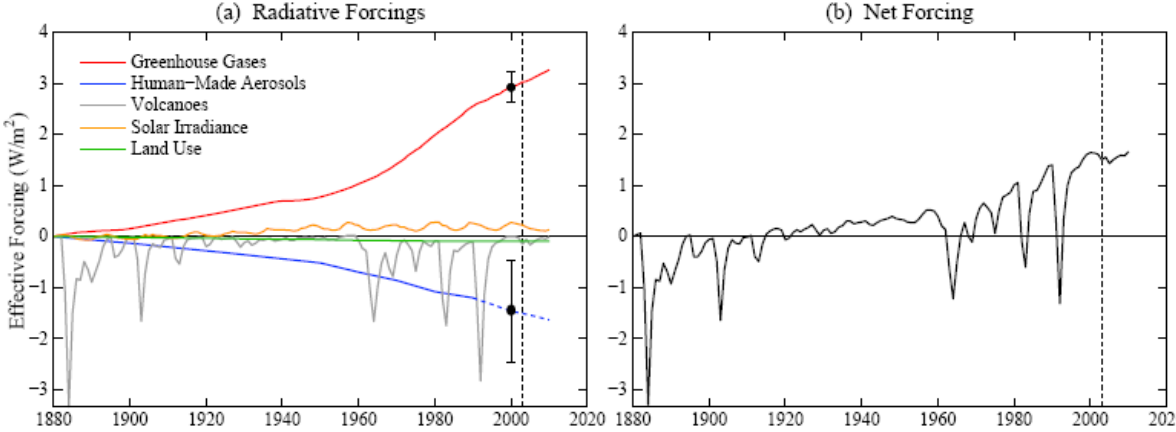
Fig. 1. Climate forcings employed in this paper. Forcings through 2003 (vertical line) are the same as used by Hansen et al. (2007), except the tropospheric aerosol forcing after 1990 is approximated as − 0.5 times the GHG forcing. Aerosol forcing includes all aerosol effects, including indirect effects on clouds and snow albedo. GHGs include O 3 and stratospheric H 2 O, in addition to well-mixed GHGs. These data are available at http://www.columbia.edu/ ∼